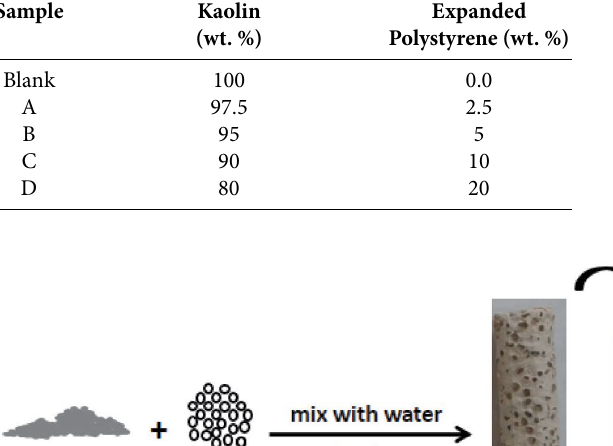
Table 1. Composition of the starting materials for preparing the po- rous ceramic membranes . Sample